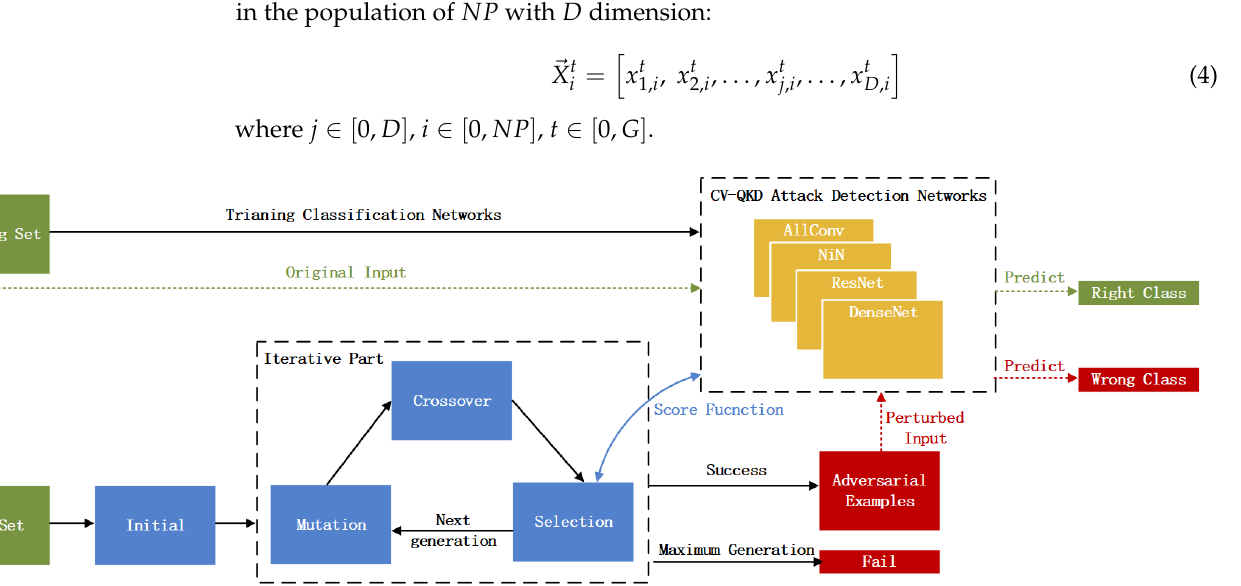
Figure 4. The frame of the one-pixel attack in CV-QKD detection networks. The blue blocks represent the four core steps of DE algorithm: initial, mutation, crossover, and